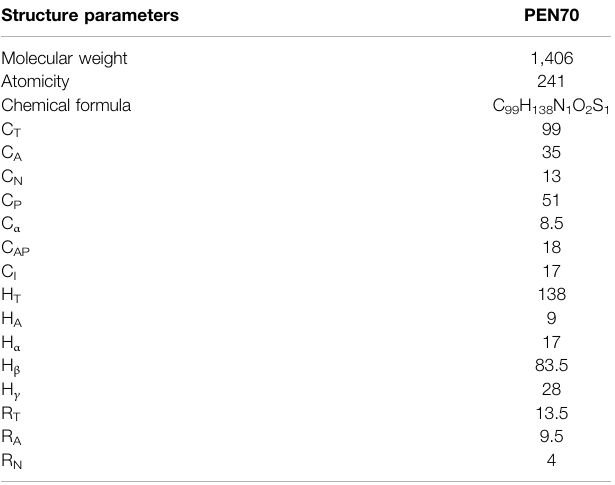
TABLE 3 | Average molecular structure parameters of PEN70 asphalt binder. Structure parameters PEN70 Molecular weight